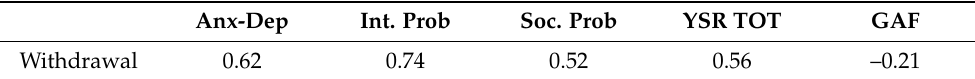
Table 4. Pearson’s r correlations between the social withdrawal scale of the YSR, the other YSR scales, and the Global Assessment of Functioning (GAF), considering the sample as a whole. Anx-Dep Int. Prob Soc. Prob YSR TOT GAF Withdrawal